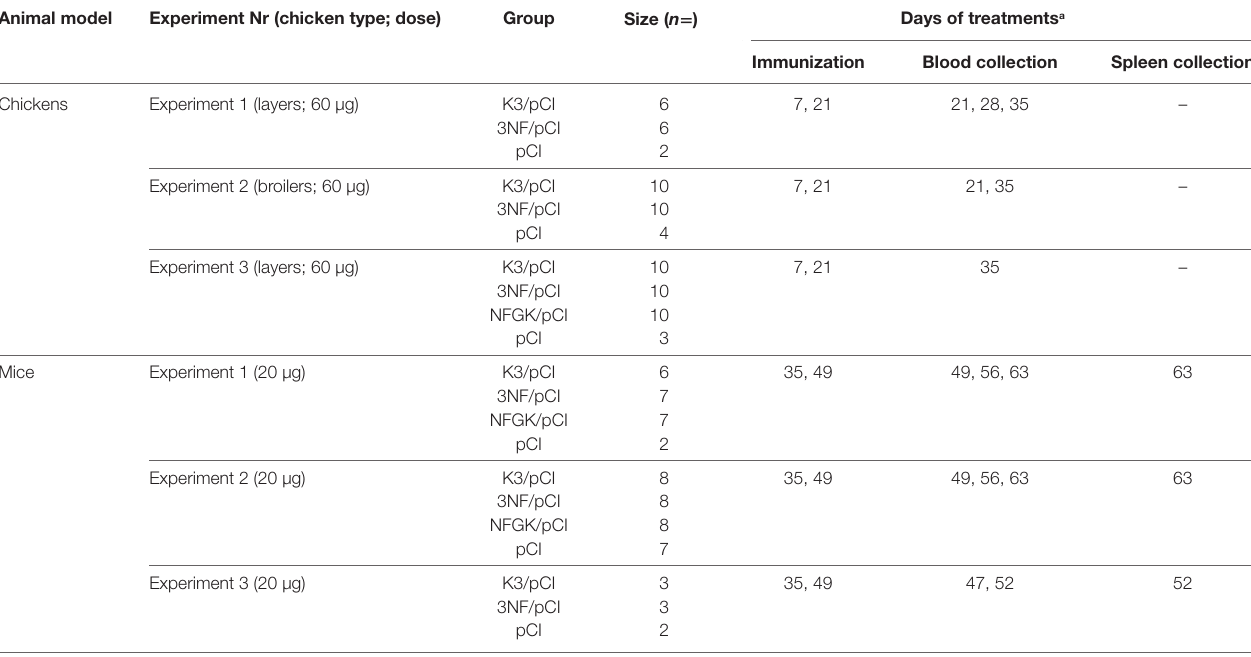
TaBle 1 | Details of the immunization